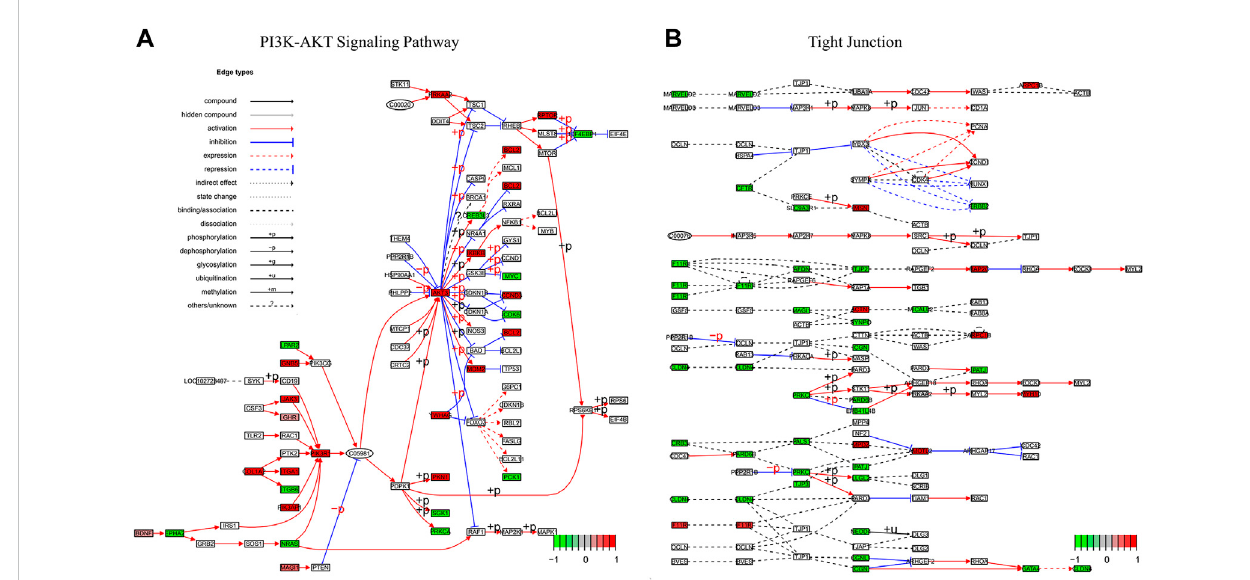
FIGURE 4 Pathview map of (A) PI3K-AKT Signaling Pathway (map 04,151) and (B) Tight Junction (map04530) using data of our cohort. Upregulated genes in red, downregulated genes in green.